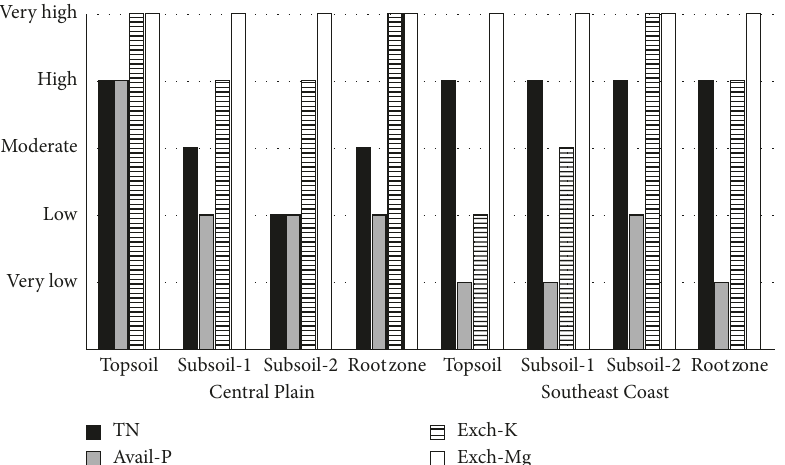
Figure 5: The soil nutrient status for fertilizer recommendations (TN � total nitrogen; Avail � available; Exch � exchangeable) of acid sulfate soils under oil palm planting areas in Central Plain and Southeast Coast, component defining variable on soil properties of subsoil-1 ( n � 10). Table S4: results of principal component analysis with concept of component defining variable on soil properties of subsoil-2 ( n � 10). Table S5: results of principal component analysis with concept of component defining variable on soil properties of rootzone ( n � 30). ( Supple-